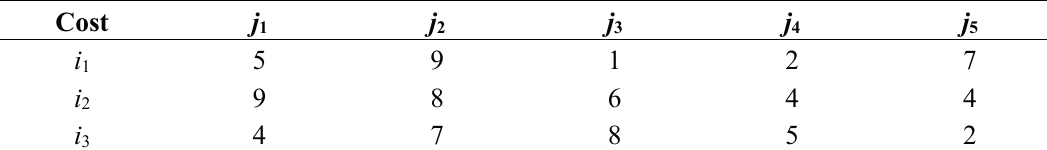
Table 1. Cost matrix A = [ c ij ] 3 × 5